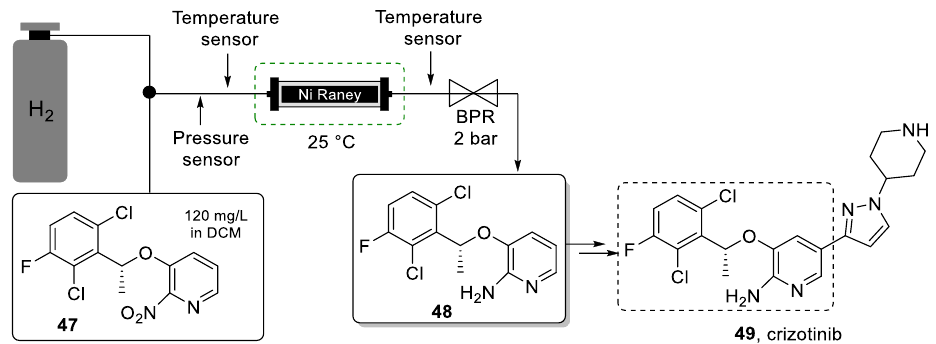
Scheme 10. Synthesis of building block 48 using a packed-bed continuous-flow reactor.